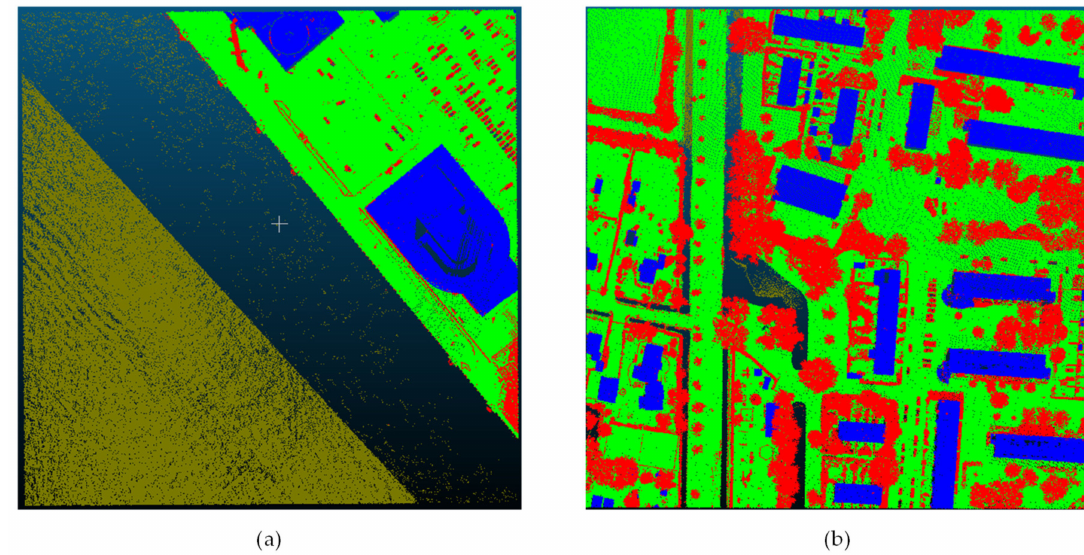
Figure 13. ( a ) Water in the training area; ( b ) Water in the testing area. Building, navy blue; tree, red; water, brown; and terrain,